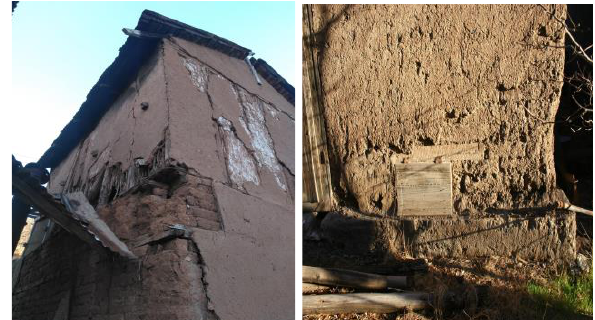
Figure 9a. Erosion in a. upper area of an adobe wall in Chalinga b. lower area of an adobe wall in Chuchiñi.